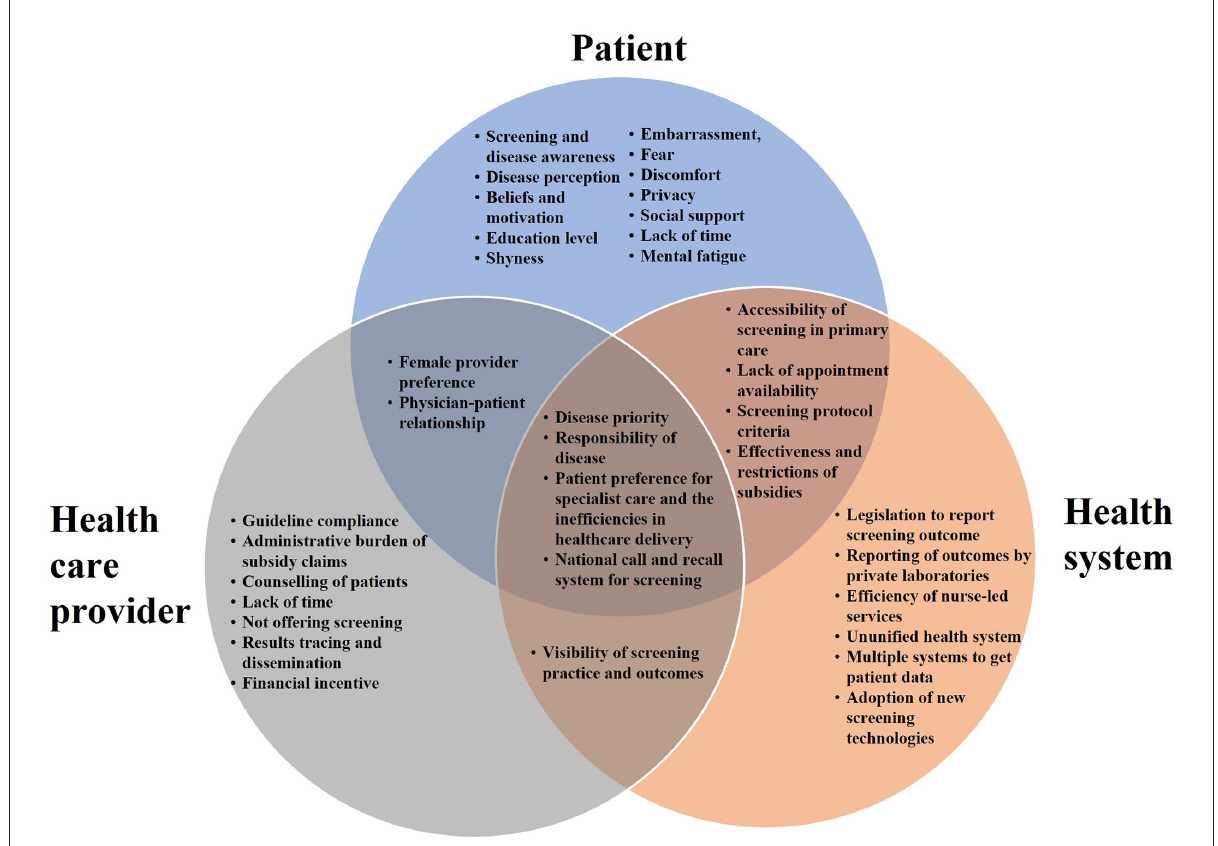
FIGURE1 Relationship between factors influencing cervical cancer screening in